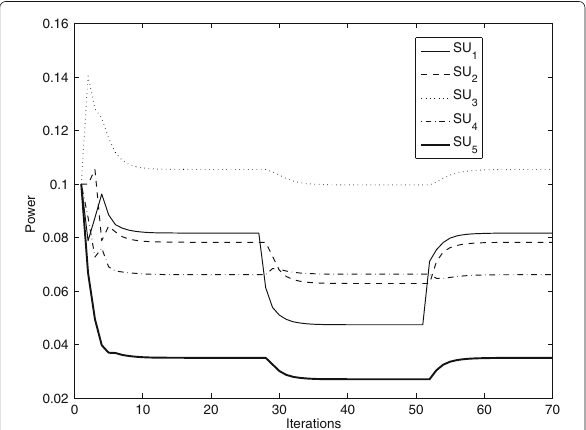
Fig. 3 The comparison of the proposed algorithm and zero-forcing algorithm for the target SINRs